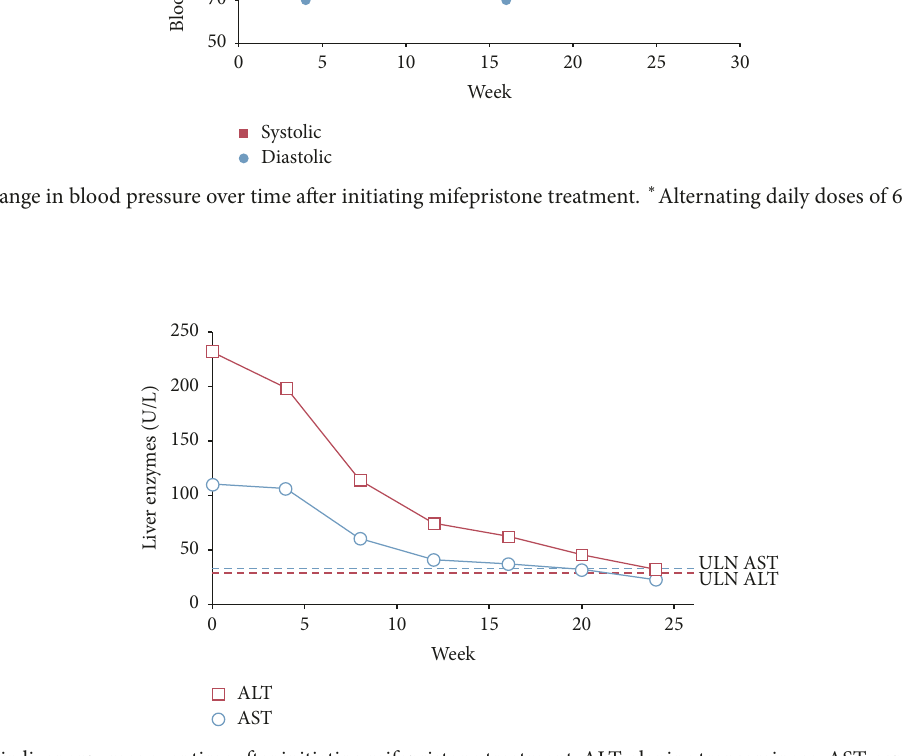
Figure 3: Change in liver enzymes over time after initiating mifepristone treatment. ALT, alanine transaminase; AST, aspartate transaminase; ULN, upper limit of normal.